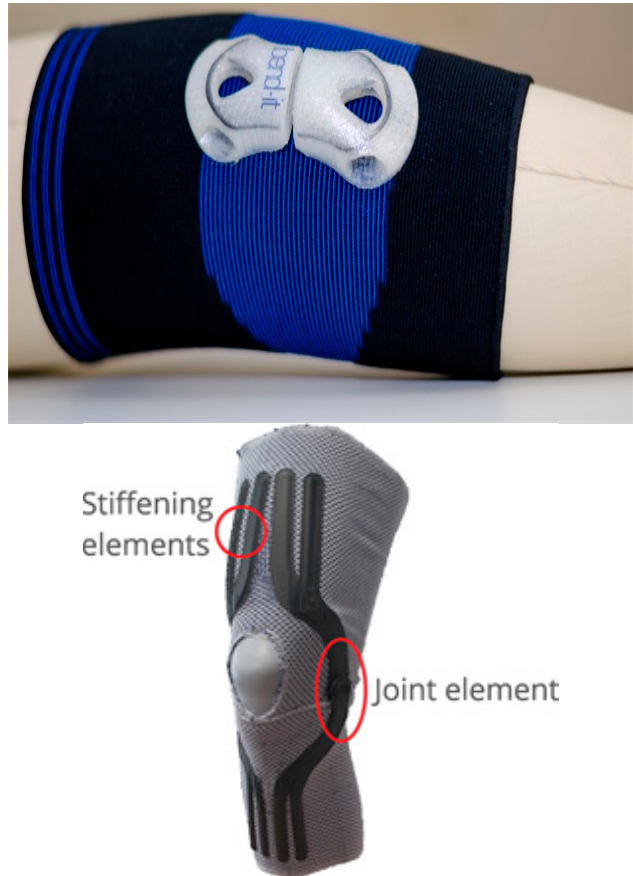
Figure 9. Combination of additive manufactured element with a knitted fabric for movement limitation and rehabilitation after injury of joints [85,86].